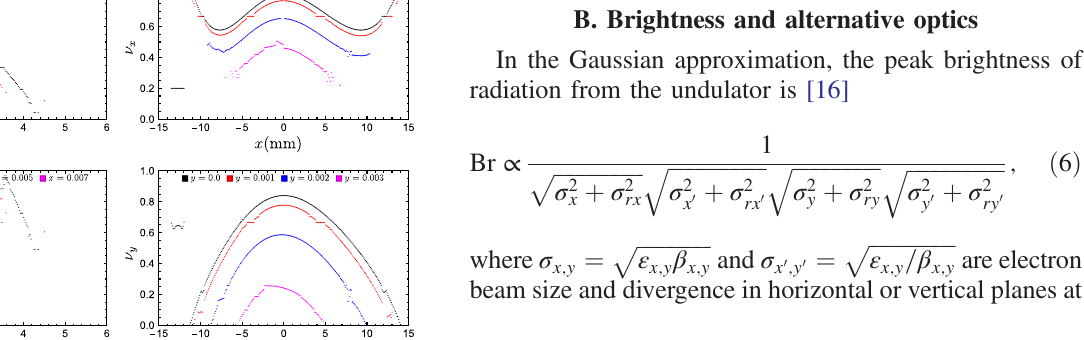
TABLE VI. rms alignment